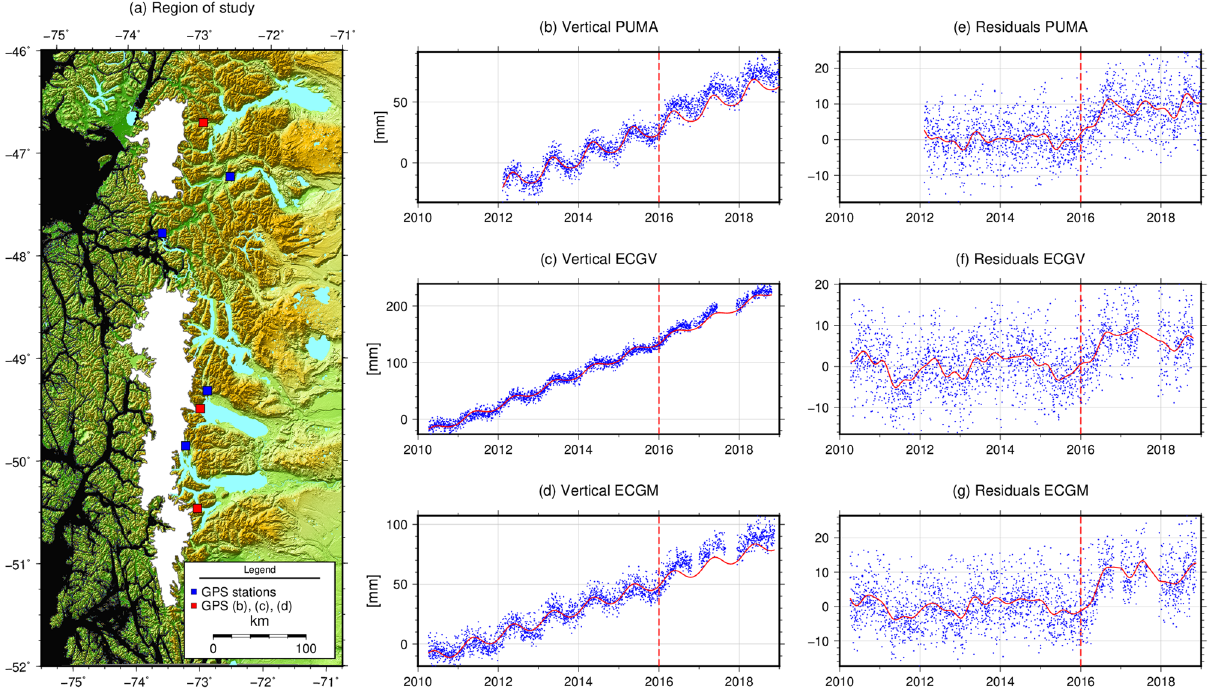
Figure 1. ( a ) Region of the Northern and Southern Patagonia Icefields (map created using the Generic Mapping Tools 37 version 6, https:// docs. gener ic- mappi ng- tools. org/6. 0/) showing the location of the CGPS stations used in this study. Stations, north to south: PUMA, COCR, TRTL, CHLT, ECGV, ECGU, ECGM. ( b – d ) North to south, vertical component of GPS stations PUMA, ECGV, ECGM; blue dots are daily solutions obtained with GAMIT-GLOBK; red curves represent the trajectory model fit for data before 2016; trajectory fit goes from start of each time series to the vertical red dashed lines; ( e – g ) residuals after removal of the trajectory model fits; red curves represent a least-squares collocation smoothed signal of the residuals to reduce noise in the GPS to a disk load (using 5 km diameter disks), we computed the vertical displacement of the crust produced by the regional changes in TWS at the seven CGPS stations between 2010 and 2019. Because GLDAS does not correctly account for ice fields and water bodies, we removed the model cells within these areas. Using the same elastic disk load and elastic models, we computed the water storage change signal for the lakes in Patagonia using lake stage observations (obtained from the Argentine National System of Hydrological Information, see http:// bdhi. hidri cosar genti na. gob. ar/). Thus, the ice load signal can be found from Eq. (1) as